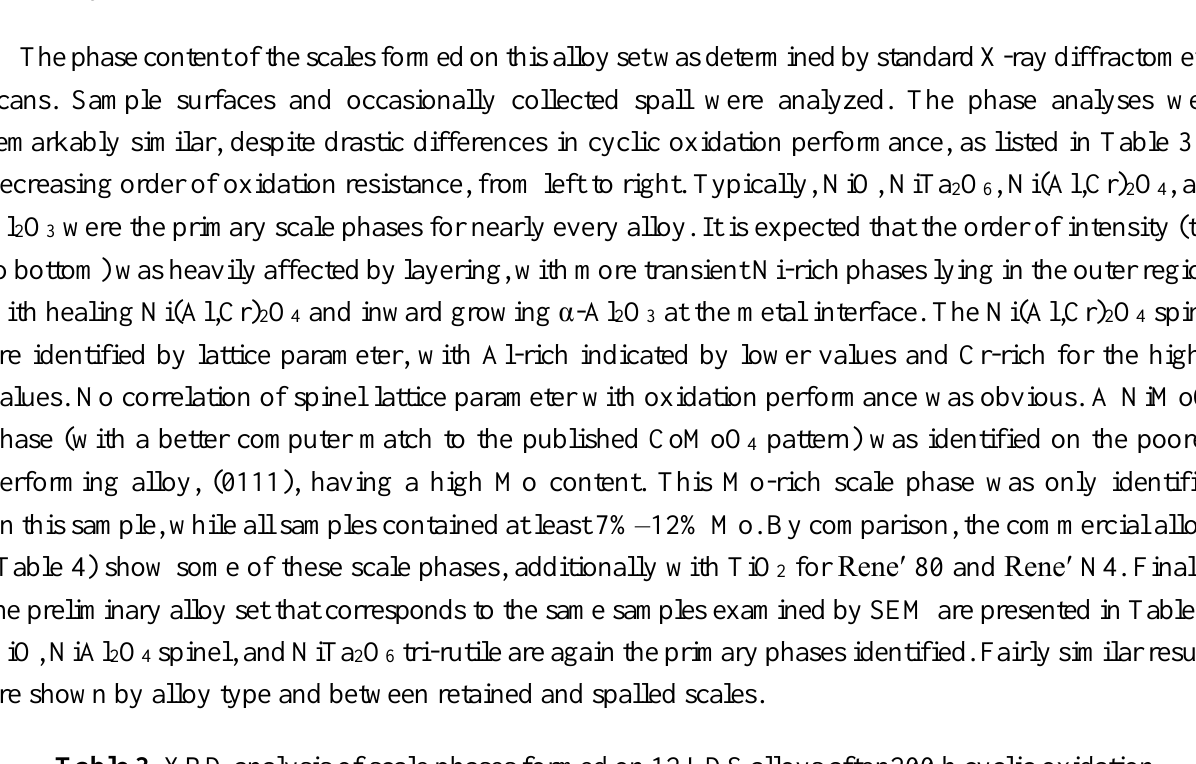
Table 3. XRD analysis of scale phases formed on 12 LDS alloys after 200 h cyclic oxidation at 1100 °C corresponding to data in Figure 1. Listed in order of pattern strength, strongest to weakest. Spinel lattice parameters generally indicate Al predominance over